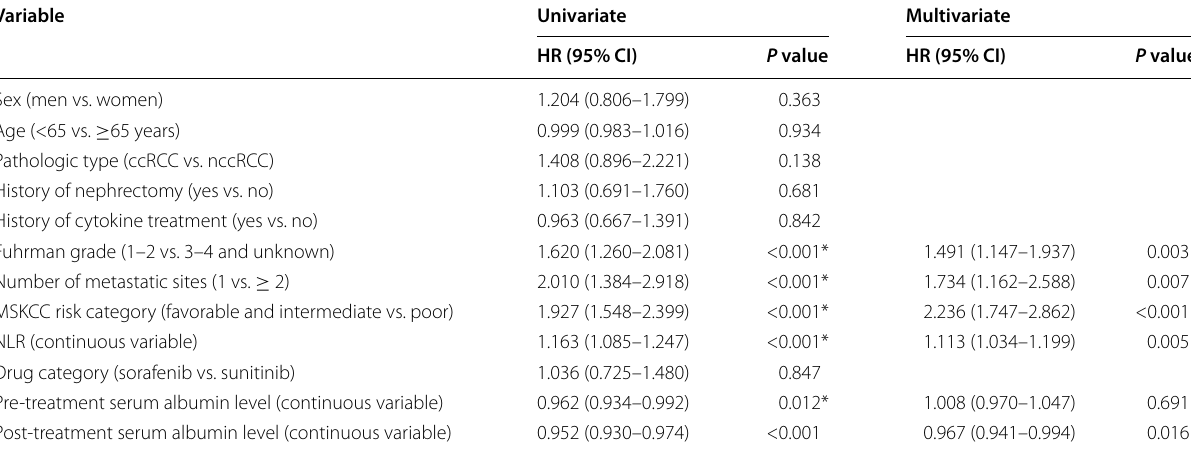
ccRCC, clear cell renal cell carcinoma; nccRCC, non-clear cell renal cell carcinoma; NLR, neutrophil-to-lymphocyte ratio; MSKCC, Memorial Sloan Kettering Cancer Center; HR, hazard ratio; CI, confidence interval * Variables with P values <0.05 in univariate analysis were considered for multivariate